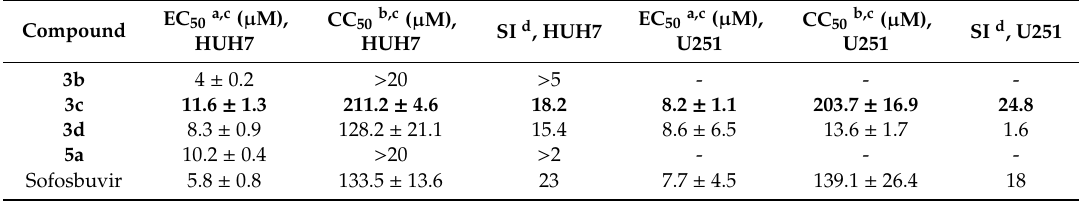
Table 3. Antiviral EC 50 and CC 50 values calculated for selected hits in the HUH7 and U251 cell lines.